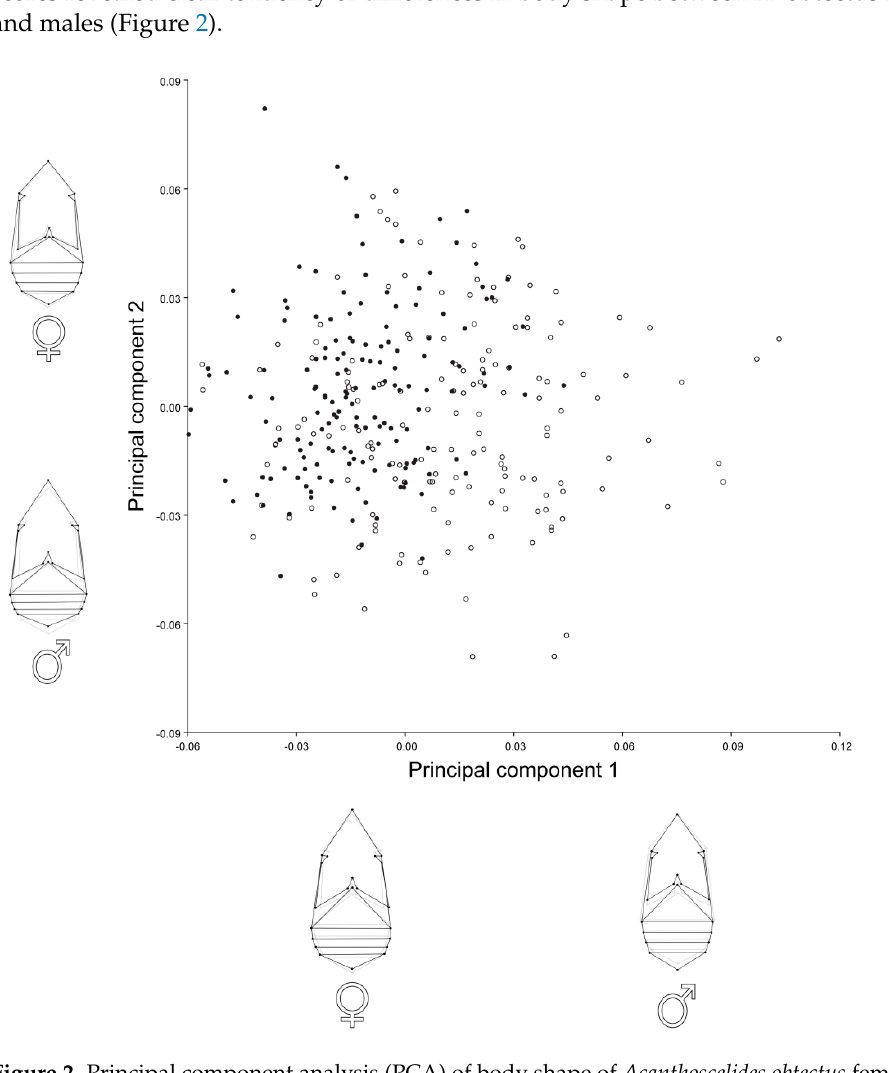
Figure 2. Principal component analysis (PCA) of body shape of Acanthoscelides obtectus females and males. Scatterplot of the PCs 1 and 2 accounted together for about 55% of the overall shape variation. Filled circles are assigned for females, while open circles are assigned for males. Shape changes of females and males associated with the PCs are represented by wireframe graphs.